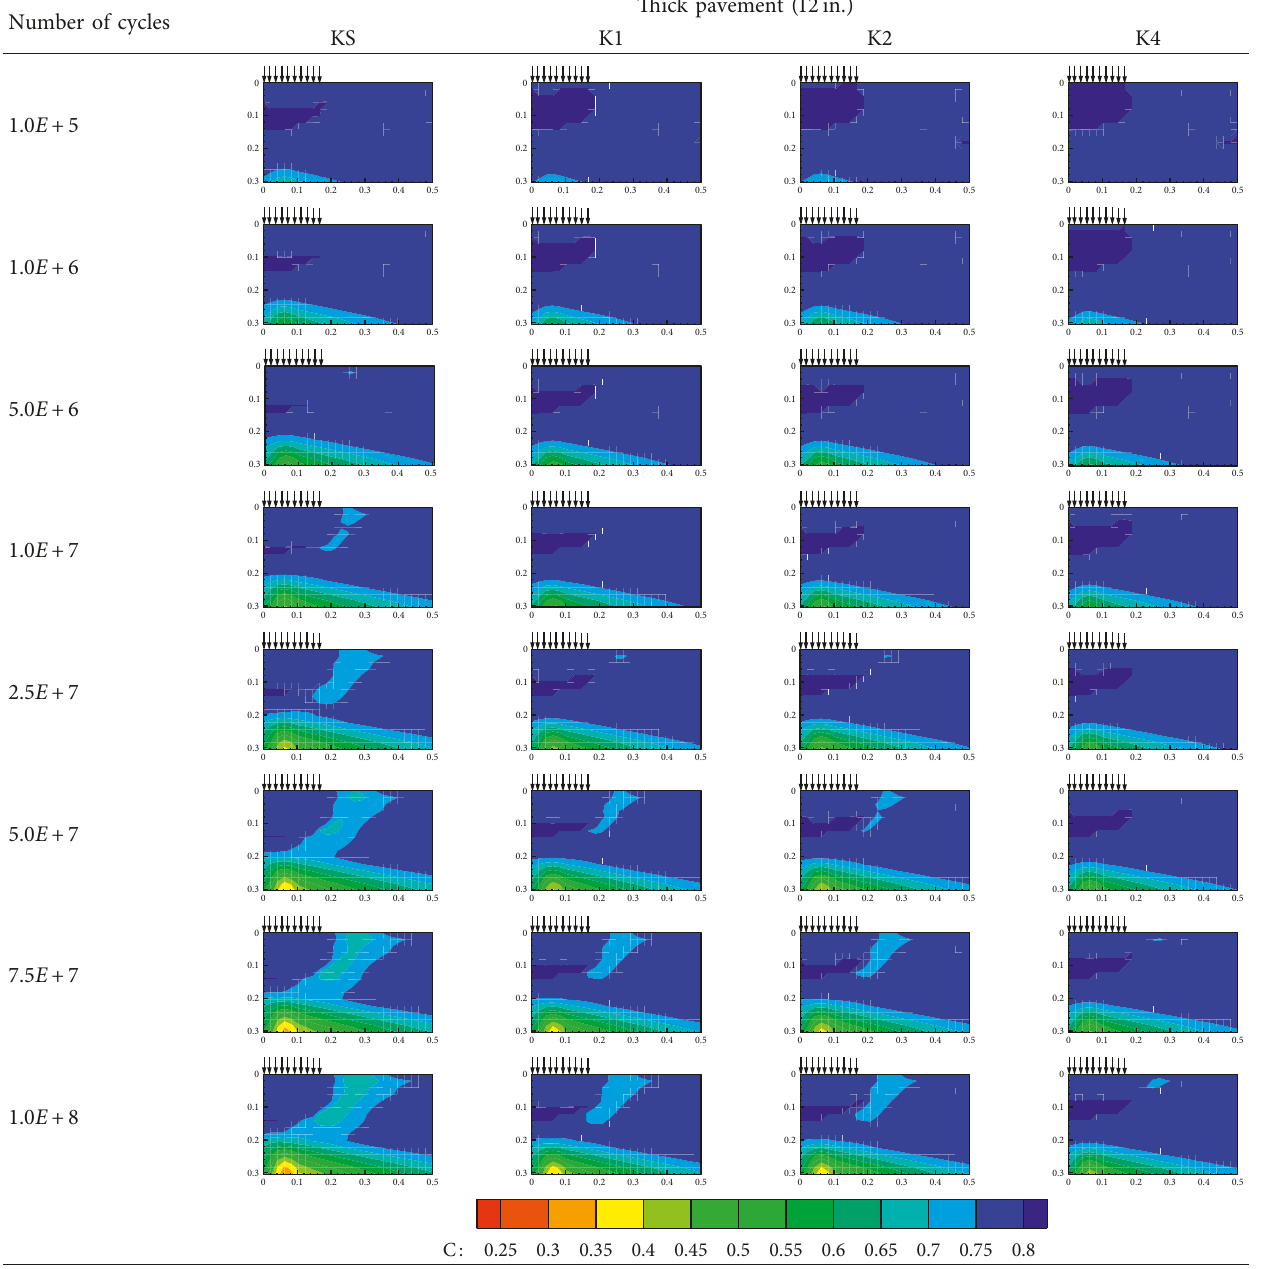
Table 7: Contour plots of C for thick pavements in color mode. Thick pavement Number of cycles